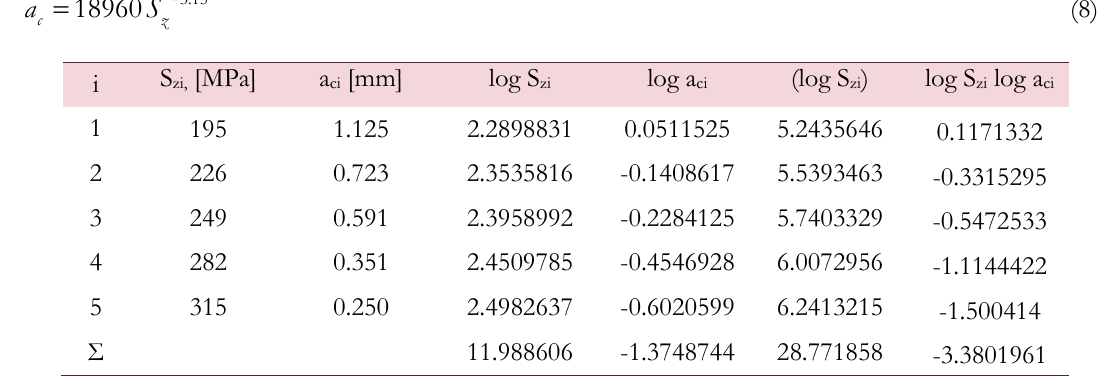
Table 4: Values for solving the equation system